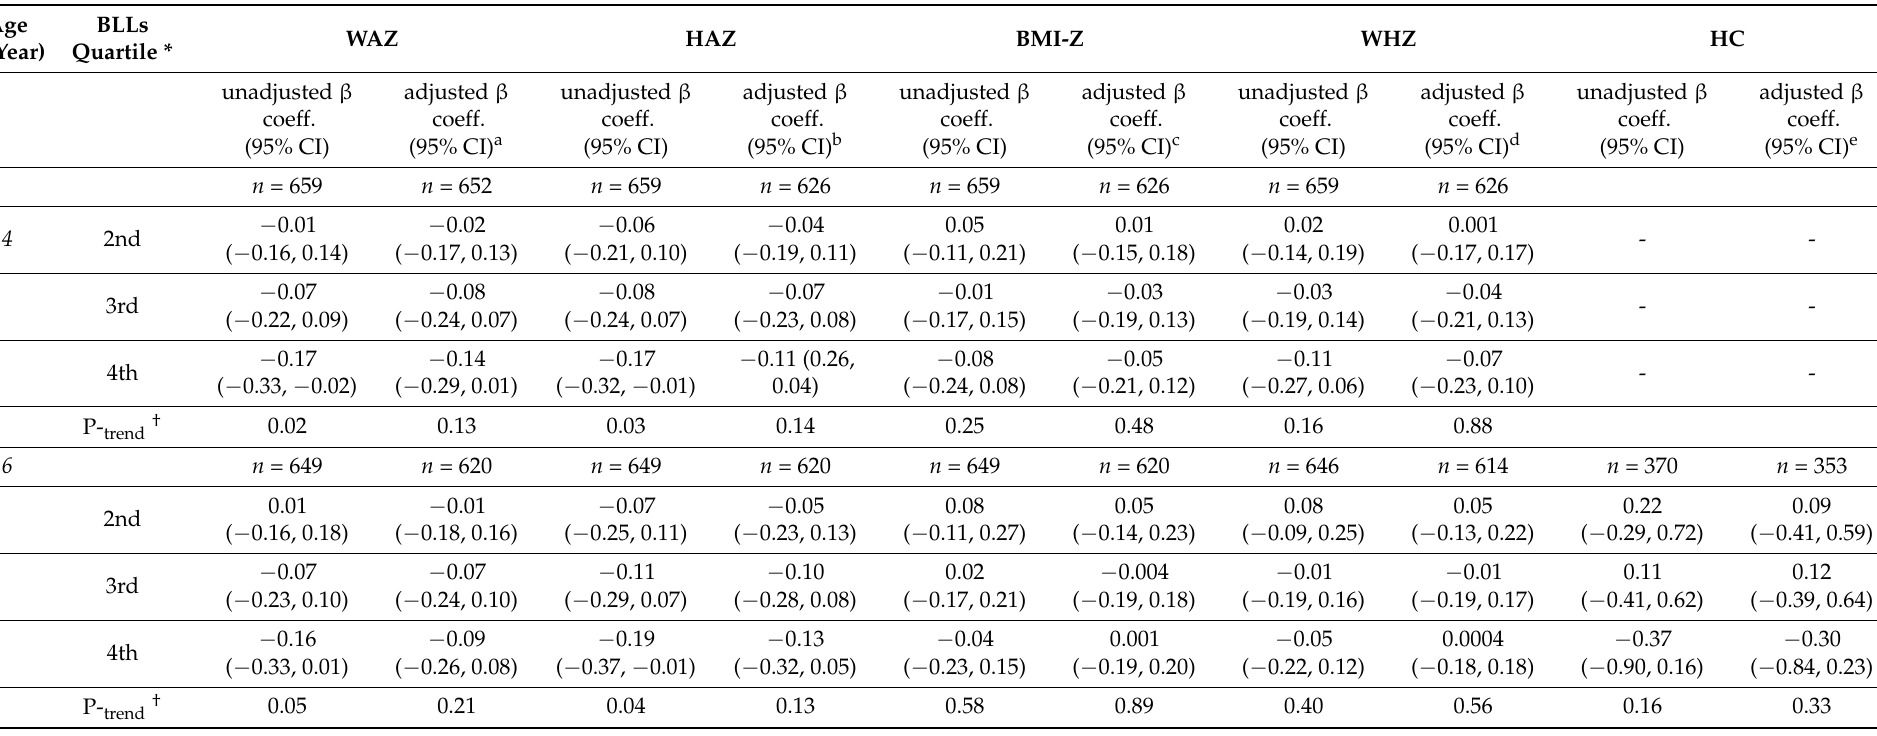
Table 2. Linear regression coefficients (95% confidence intervals) for the associations between blood lead levels at age 1 year and growth at age 4 and 6 years in Beninese children (Allada